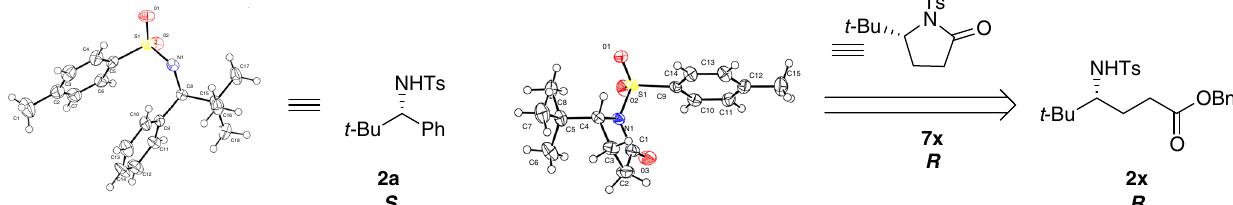
Fig. 4 X-ray crystallographic analysis. ORTEP representation of 2a and 7x